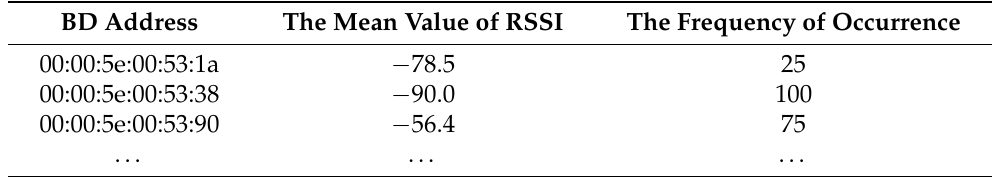
Table 2. Example of sensing data acquired between